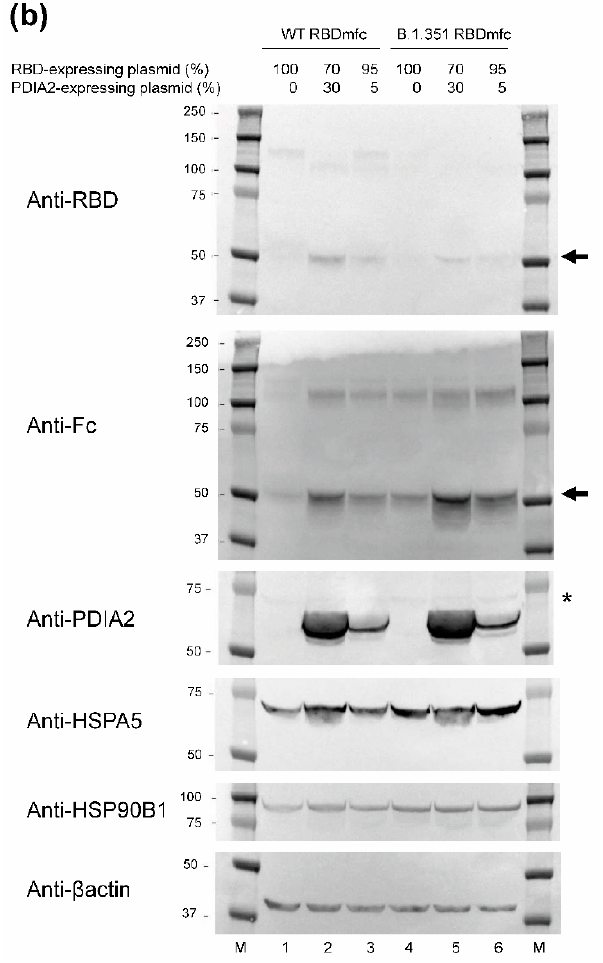
Figure 4. Western blots of secreted ( a ) and intracellular ( b ) protein fractions of Expi293F cells expressing WT and B.1.351 RBDmfc together with increasing amounts of PDIA2. Secreted and intracellular protein fractions described in Figure 3 were analysed by Western blot using antibodies directed against the recombinant RBDmfc proteins (anti-RBD, anti-Fc), against chaperones (anti-PDIA2, anti-HSPA5, anti-HSP90B1), and against β actin as loading control. M, protein ladder (apparent MW in kDa indicated on the left); *, endogenous PDIA2 protein (anti-PDIA2 blot); arrow, RBDmfc proteins (anti-RBD and anti-Fc blots in panel ( b )) likely lacking disulphide bonds and mature glycosylations, and thus running in SDS-PAGE with an apparent MW of 50 kDa (compare to 59 kDa reduced, mature proteins shown in Figure 2, lanes 3 and 4). Quantification of signal intensity of chaperones is shown in Figure S2. Data are from one representative experiment (out of three independent experiments). Uncropped blot images are shown in Appendix Figures A3 and A4.